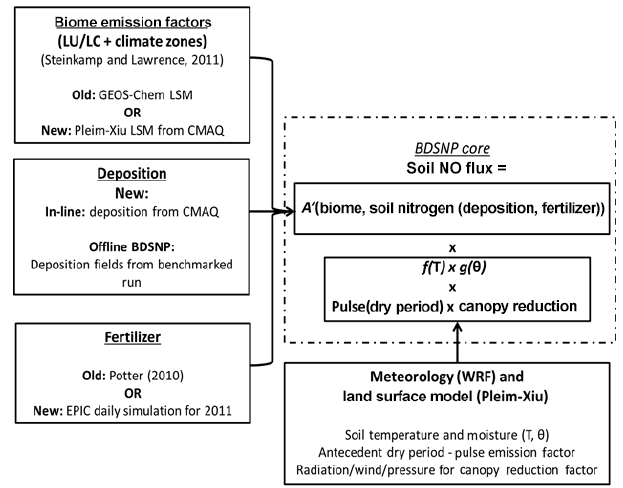
Figure 1. Soil NO emissions modeling framework as implemented offline or in CMAQ (in-line). “Old” refers to the Hudman et al. (2012) implementation in GEOS-Chem. “New” refers to our im- plementation in